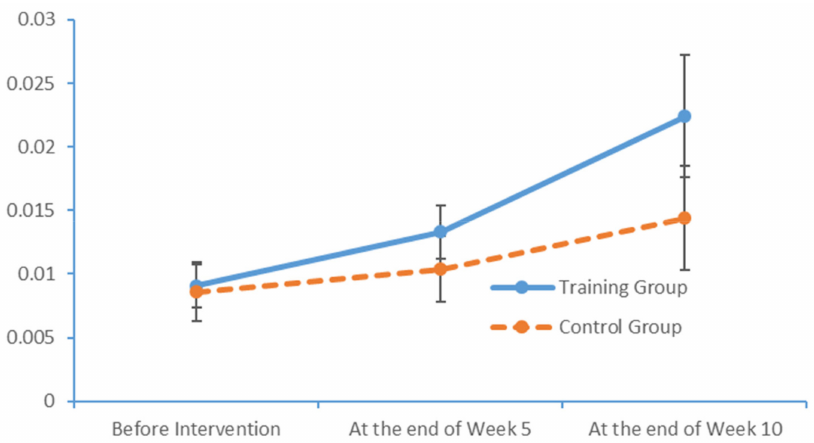
Figure 13. Changes in the power values of the beta_hemi_left wavebands measured in the two subject groups at several time points.